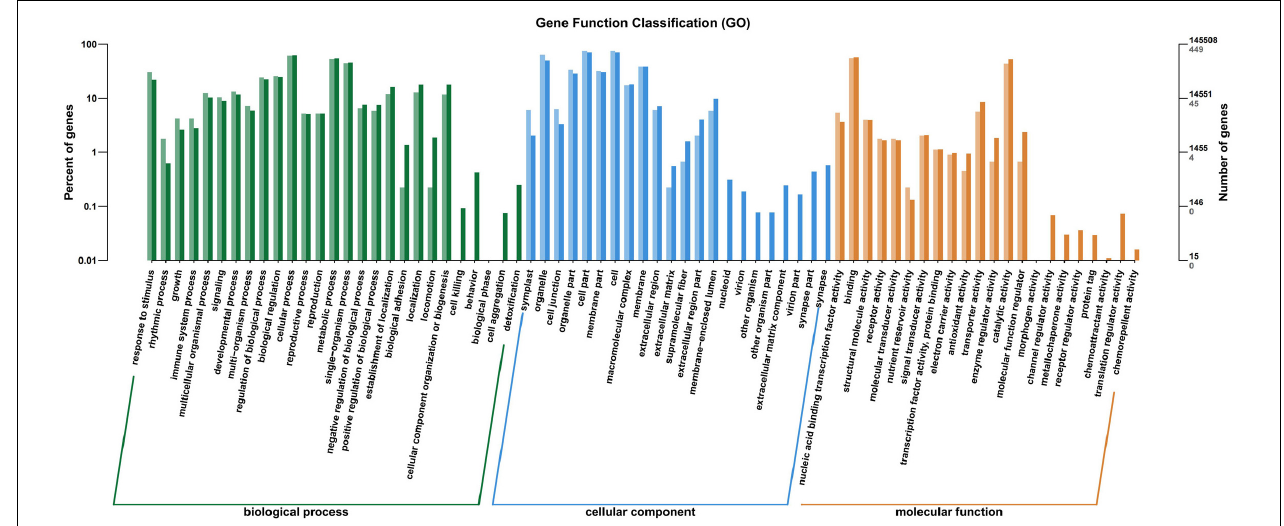
FIGURE 5 | Gene ontology categories of differentially expressed genes (DEGs) in the leaves of Cyclocarya paliurus between low and high altitudes.